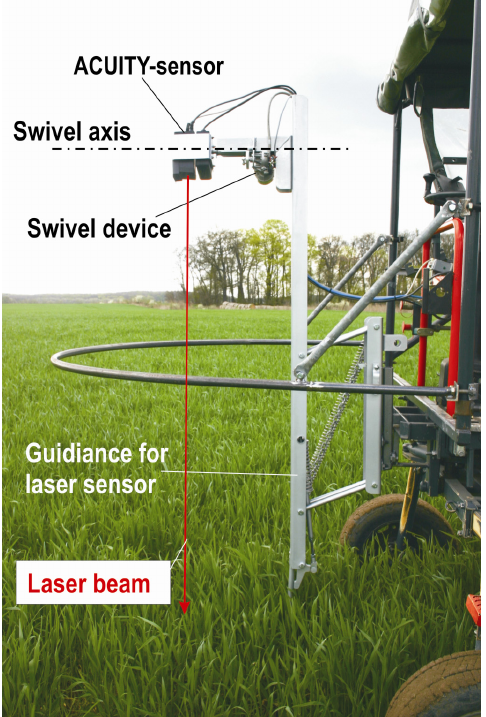
Figure 1. Arrangement of laser rangefinder and swivel device (horizontal axis) on a basic vehicle for measuring crop